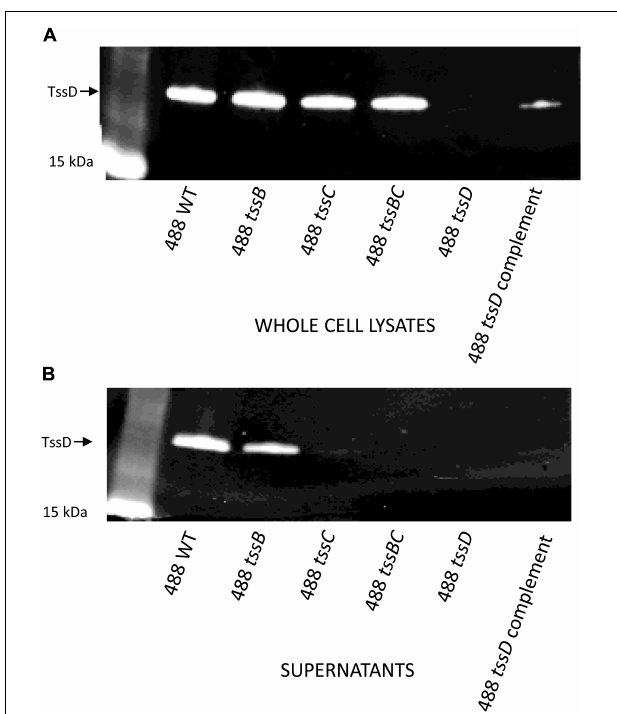
FIGURE 3 | Detection of TssD in C. jejuni whole cell lysates and supernatants. (A) Detection of TssD in C. jejuni whole cell lysates. Whole cell lysate samples were prepared from 16 h cultures of C. jejuni 488 wild-type strain, 488 tssB mutant, 488 tssC mutant, 488 tssBC double mutant, 488 tssD mutant, and 488 tssD complement grown in Brucella broth. 13 µ g of samples were loaded onto SDS-PAGE. Western blotting was performed using a TssD antibody, with a recombinant TssD protein used as a positive control. (B) Detection of TssD in C. jejuni supernatants. Bacterial supernatant samples were prepared from 16 h cultures of C. jejuni 488 wild-type strain, 488 tssB mutant, 488 tssC mutant and 488 tssBC double mutant grown in Brucella broth. Supernatant samples were concentrated via TCA precipitation and 30 µ g of samples were loaded onto SDS-PAGE. Western blotting was performed using a C. jejuni TssD antibody. C. jejuni TssD has an estimated molecular weight of 18